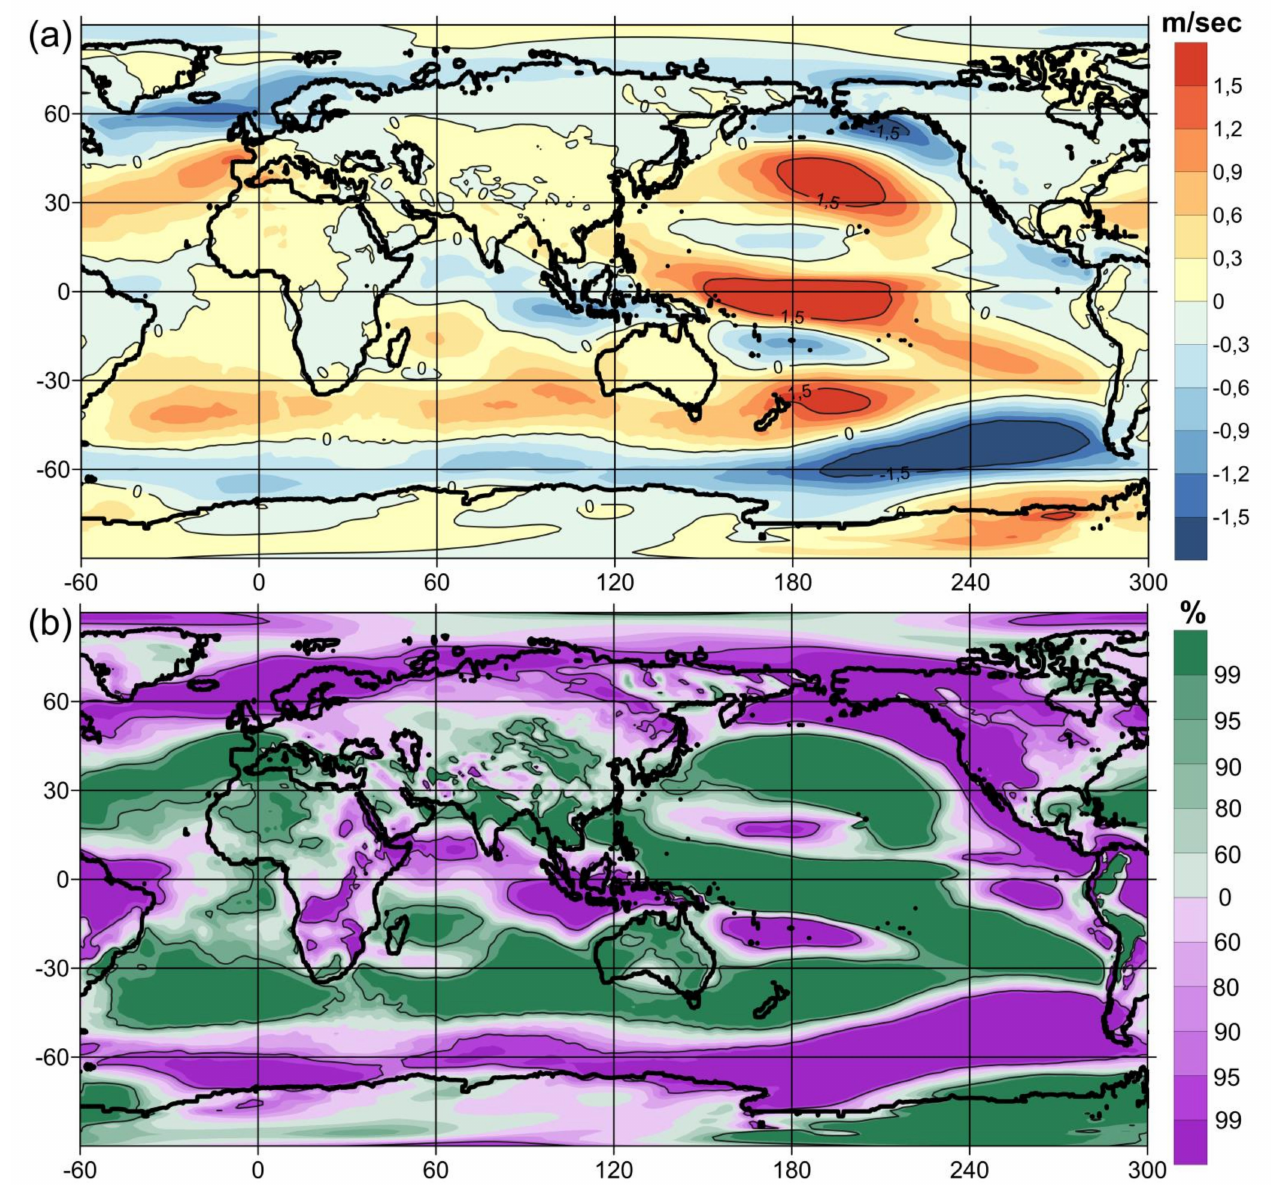
Figure 6. The difference between the average anomalies of the zonal (direction from west to east) wind speed component at a height of 10 m from the surface between the opposite phases of the Global Atmospheric Oscillation by GAO2 index ( a ). The probability values for ( a ) according to Student’s t -test ( b